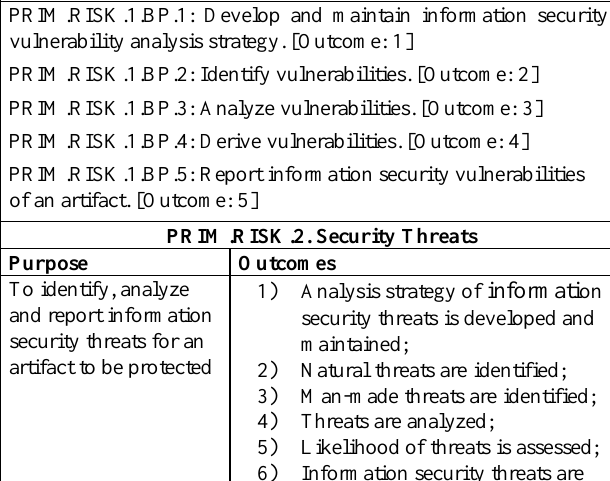
Fig. 1. Information Security Process Capability Model: relationship of the Primary Process category